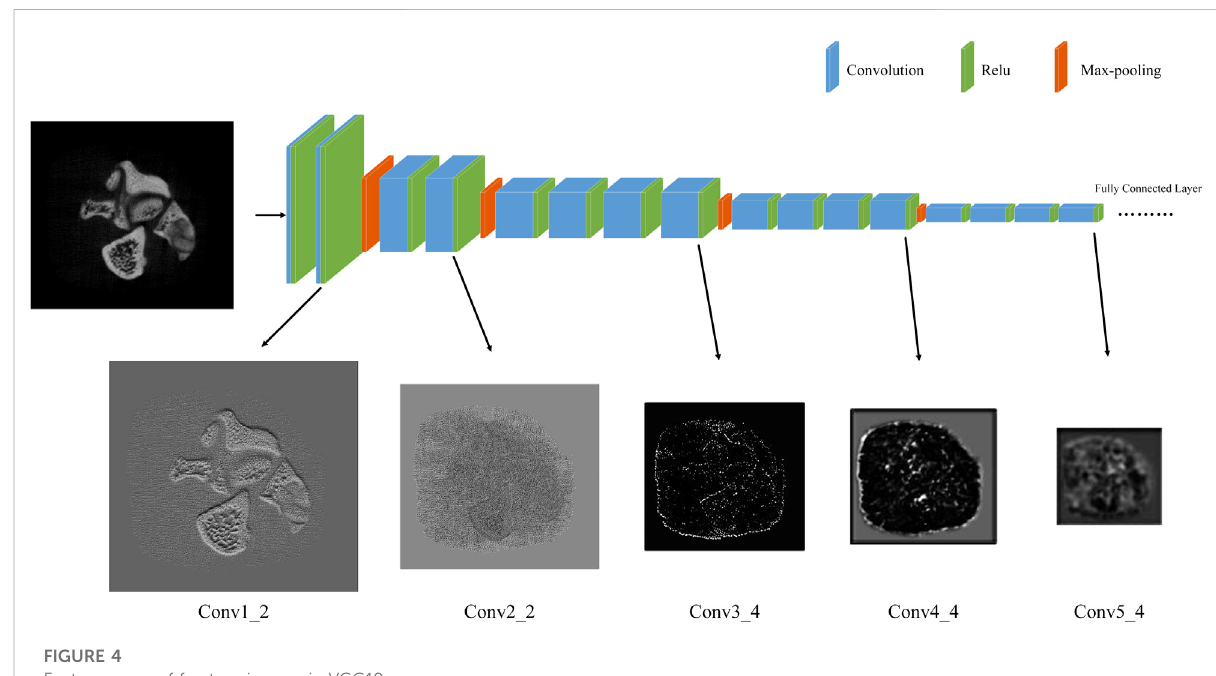
FIGURE 4 Feature maps of fracture images in VGG19.